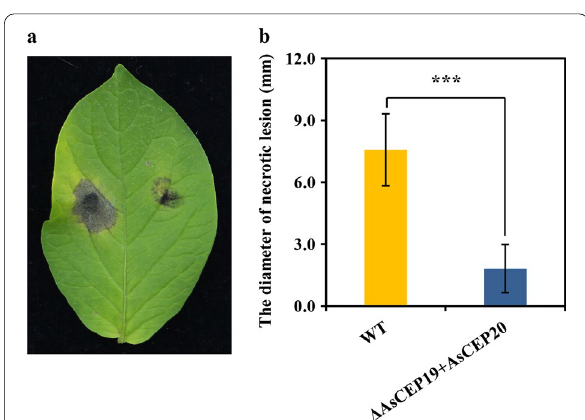
Fig. 8 Variation in virulence between the gene pair ( AsCEP19 and AsCEP20 )-knockout mutant and wild-type of A. solani on potato leaves. a Detached potato leaves inoculated with conidial suspensions of the wild-type strain (left) and the Δ AsCEP19 AsCEP20 + mutant (right). The sizes of necrotic lesions were measured at 5 dpi. b The average size of necrotic lesions caused by the Δ AsCEP19 AsCEP20 mutant and the wild-type strain. Error bars + indicate the standard deviation of the mean, and asterisks indicate statistical significance determined by paired t -test ( t 16.16, = p -value 2.5e − 11 , df 16, n 17), with three (***) P < = = =